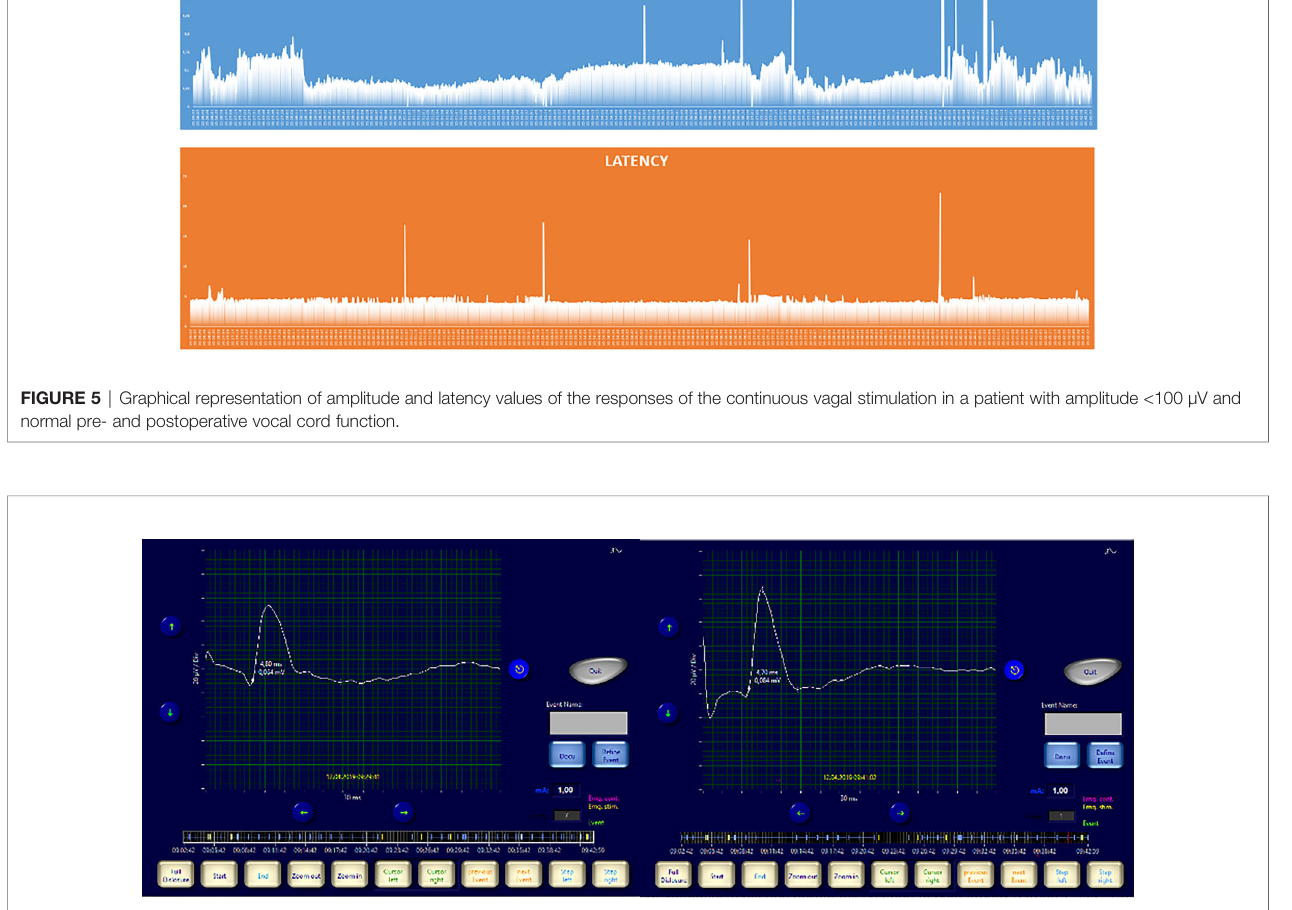
FIGURE 6 | Right vagus nerve signal (Amplitude <100 µV): before and after lobectomy.